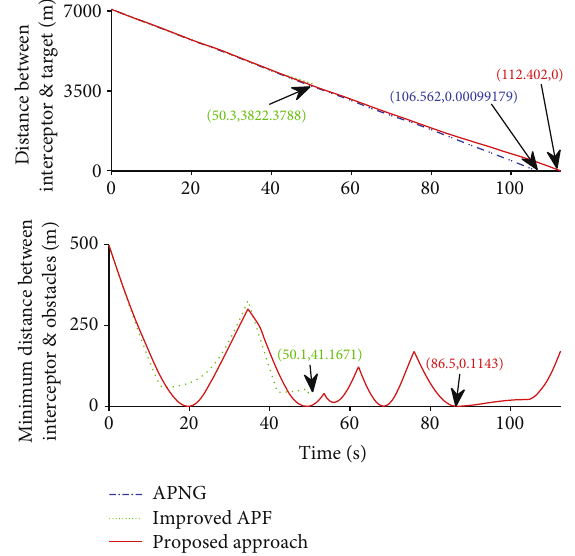
Figure 29: Changes of two distances in case 6.